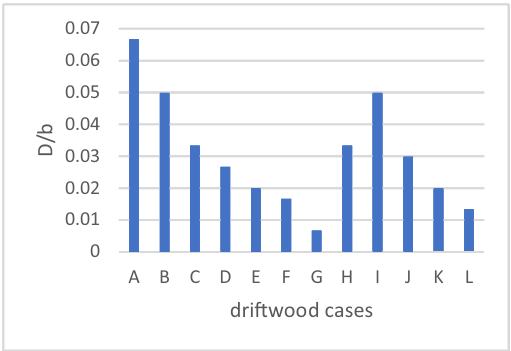
Figure 4: The relation of driftwood diameter to sluice gate width for all driftwood cases.